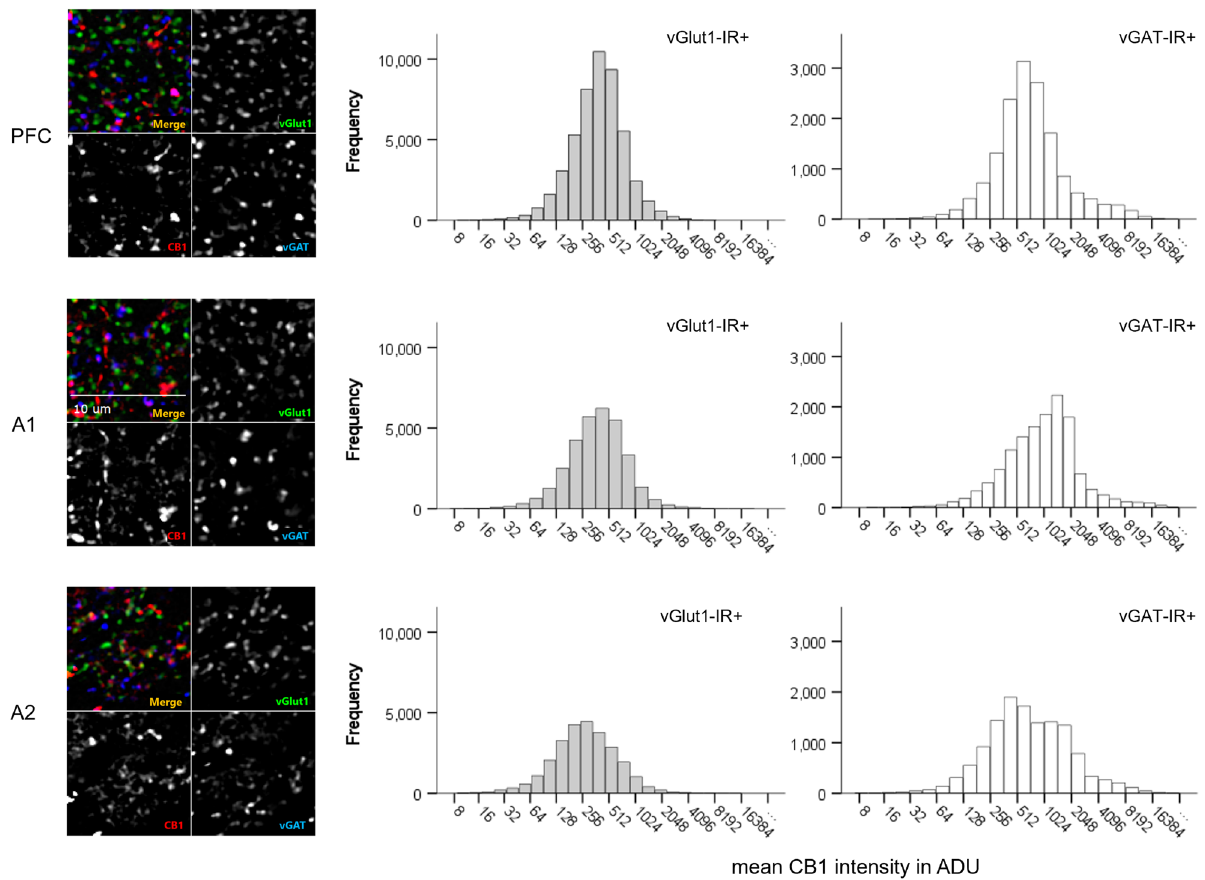
Figure 2. Mean CB1R intensity frequency histograms for excitatory (vGlut1-IR +) and inhibitory (vGAT-IR +) cell types across three brain regions of the monkey cortex, measured in analogue-to-digital units (ADU). PFC = prefrontal cortex, A1 = primary auditory cortex, A2 = association auditory cortex. Scale bar can be seen in the sample image for